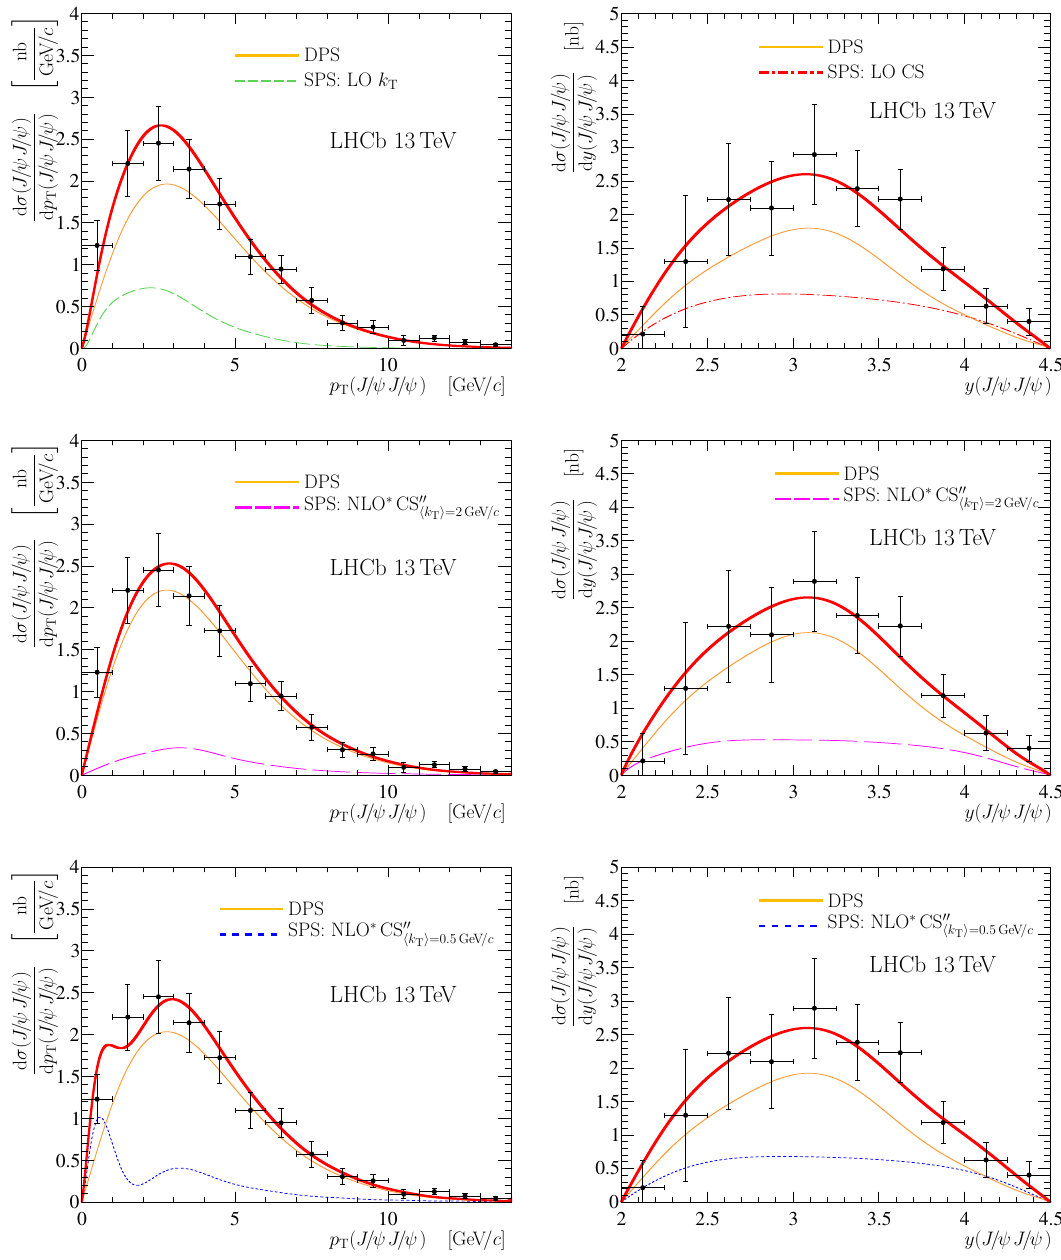
Figure 9. Result of templated DPS (cid:12)t for d (cid:27) ( J= J= ) error bars represent the data. The total (cid:12)t result is shown with the thick (red) solid line and the DPS component is shown with the thin (orange) solid